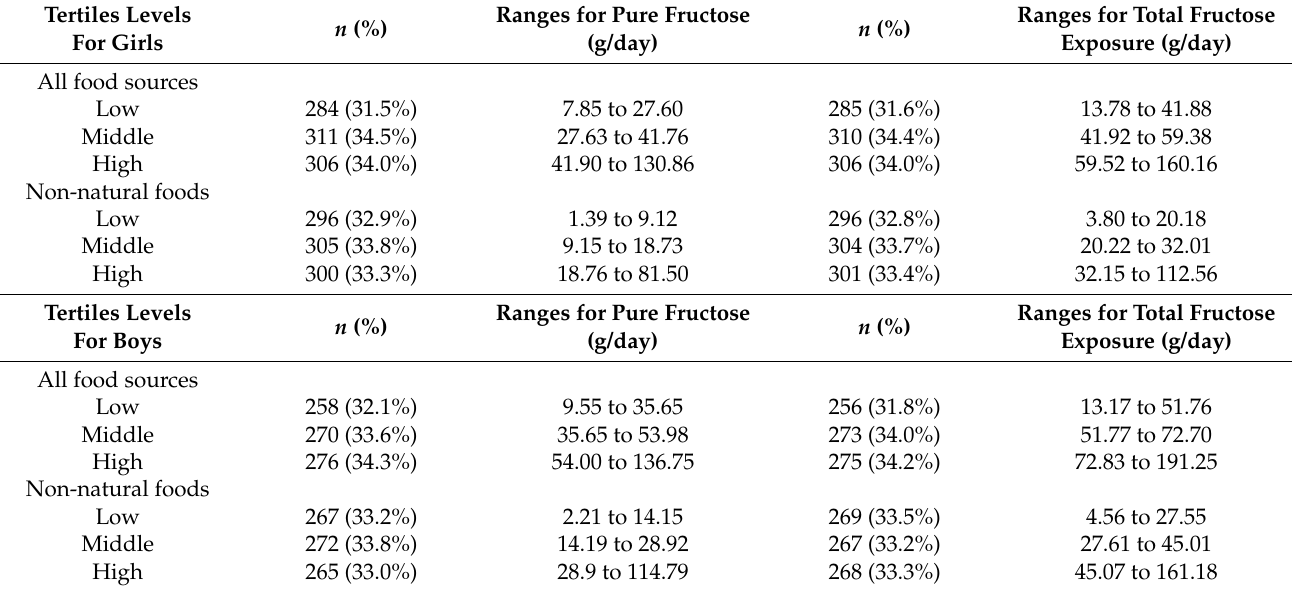
Table 2. Tertiles of daily pure fructose intake from all food sources and from non-natural foods sources. Tertiles